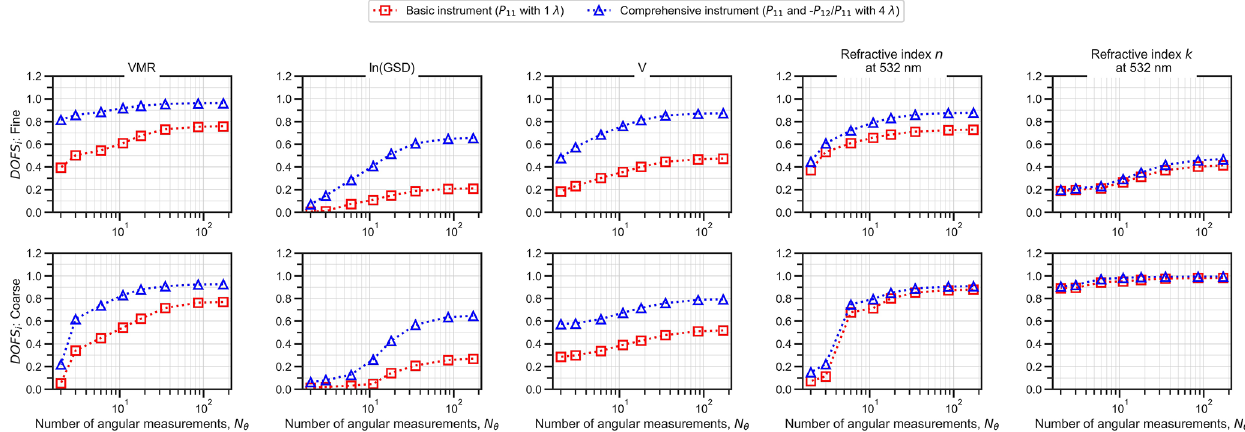
Figure 9. Variation in DOFS i for unimodal, non-absorbing-aerosol test cases as a function of the number of angular measurements N θ . The top row demonstrates the results for the fine-aerosol test case, while the bottom row corresponds to results for the coarse-aerosol test case. These results were obtained using default measurement noise values and the “high level of prior knowledge” method for selecting a priori